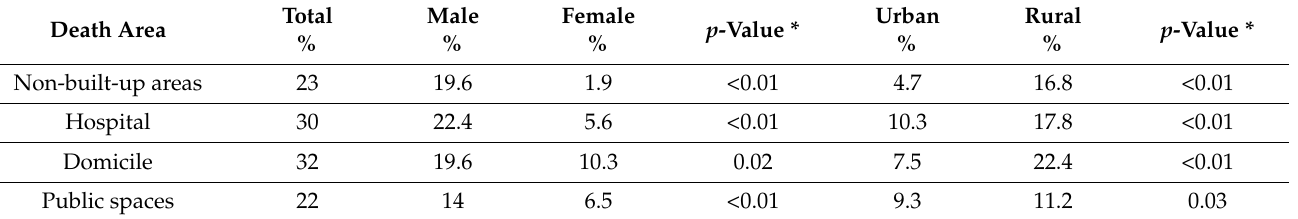
Table 1. The distribution of death area and urban vs. rural location in hypothermia-related fatalities.